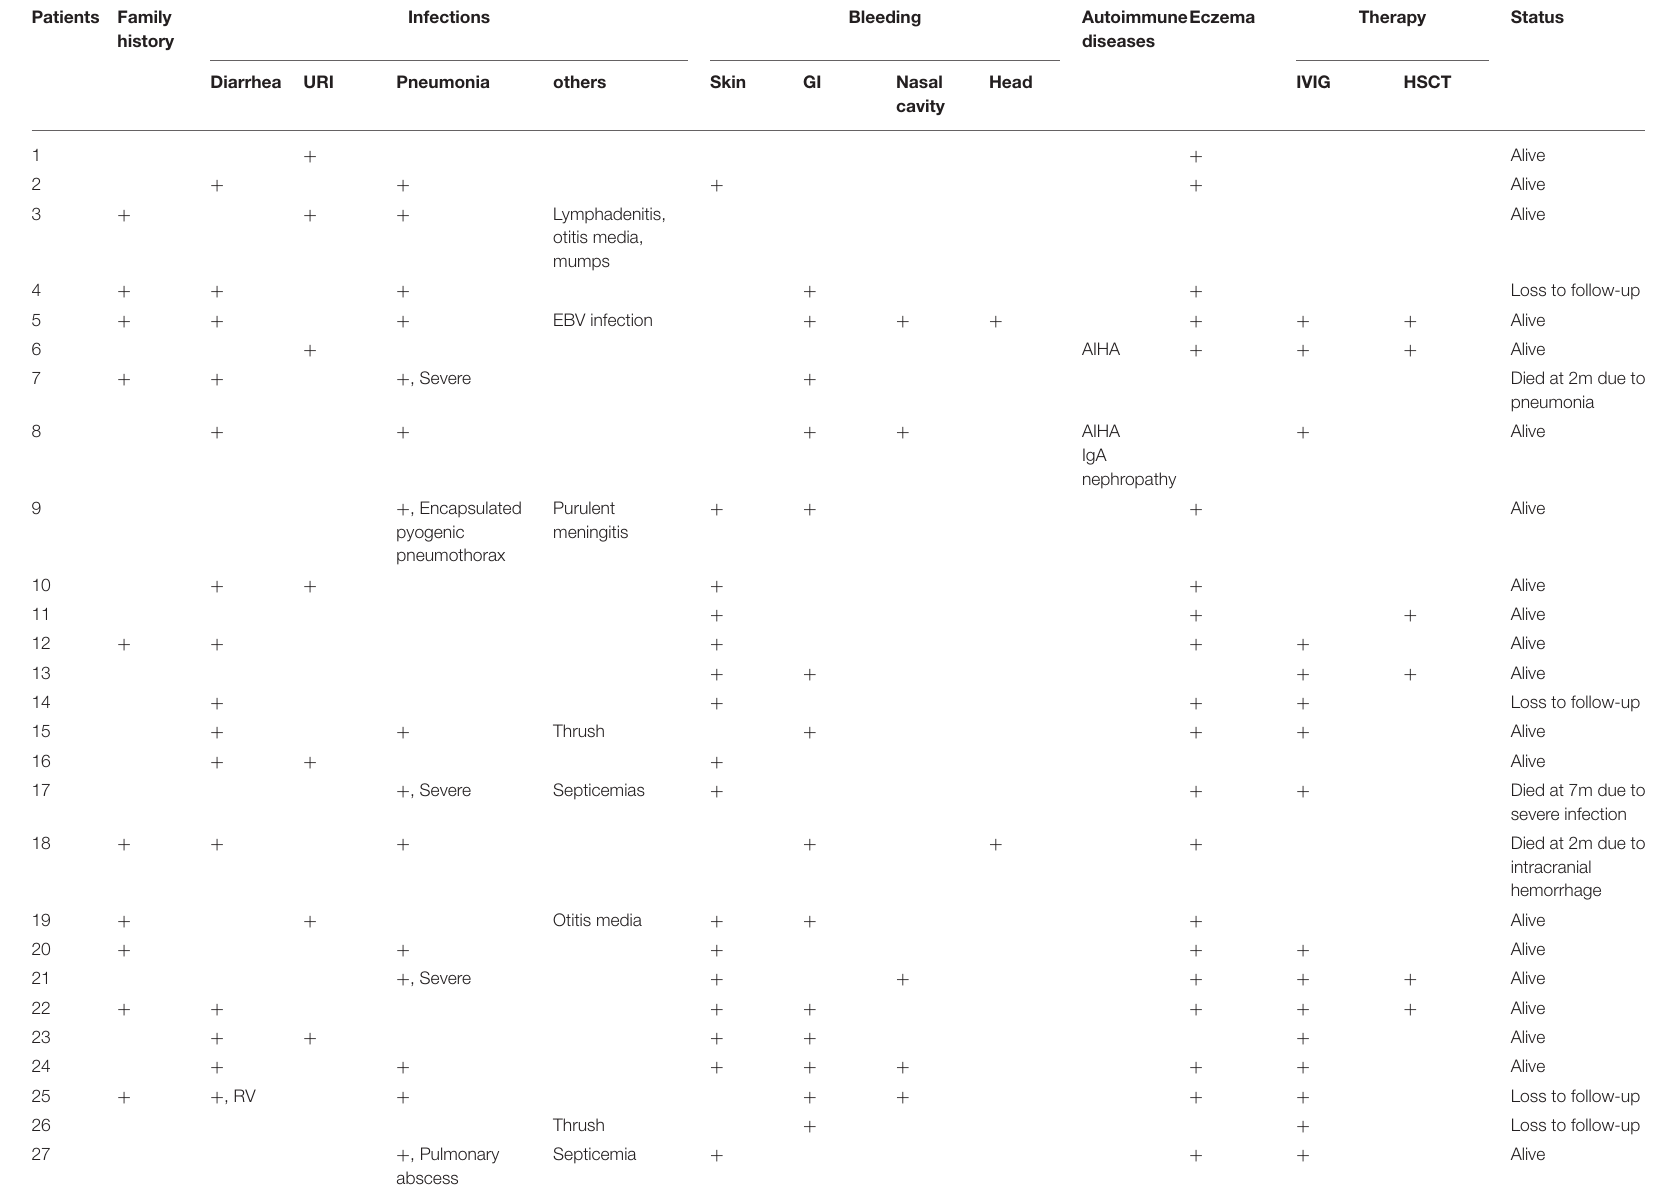
TABLE 1 | Clinical features of 42 WAS